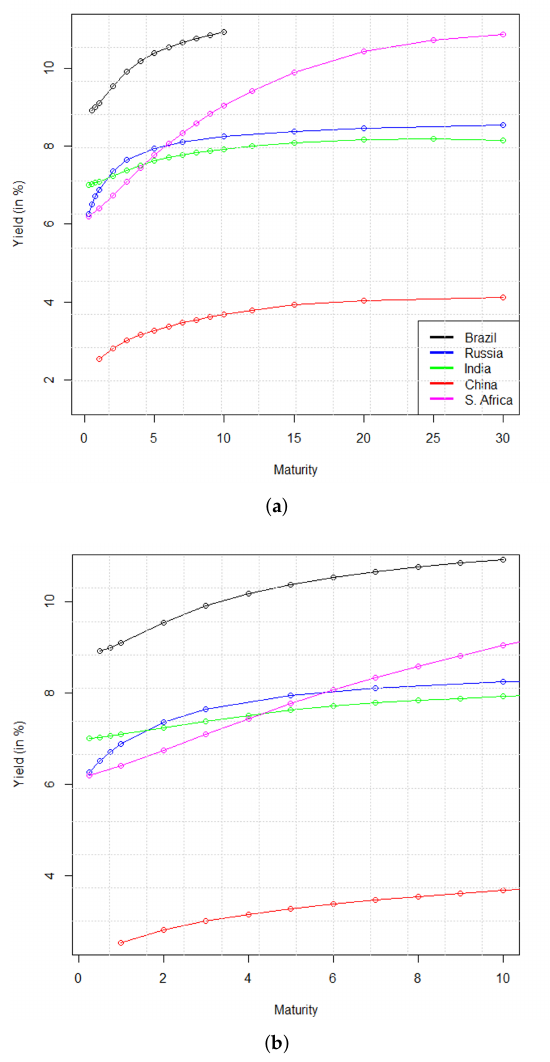
Figure 5. Plot of the BRICS average observable yield curves ( a ) and a zoomed-in area ( b ) which covers the maturity spectrum common to all the examined